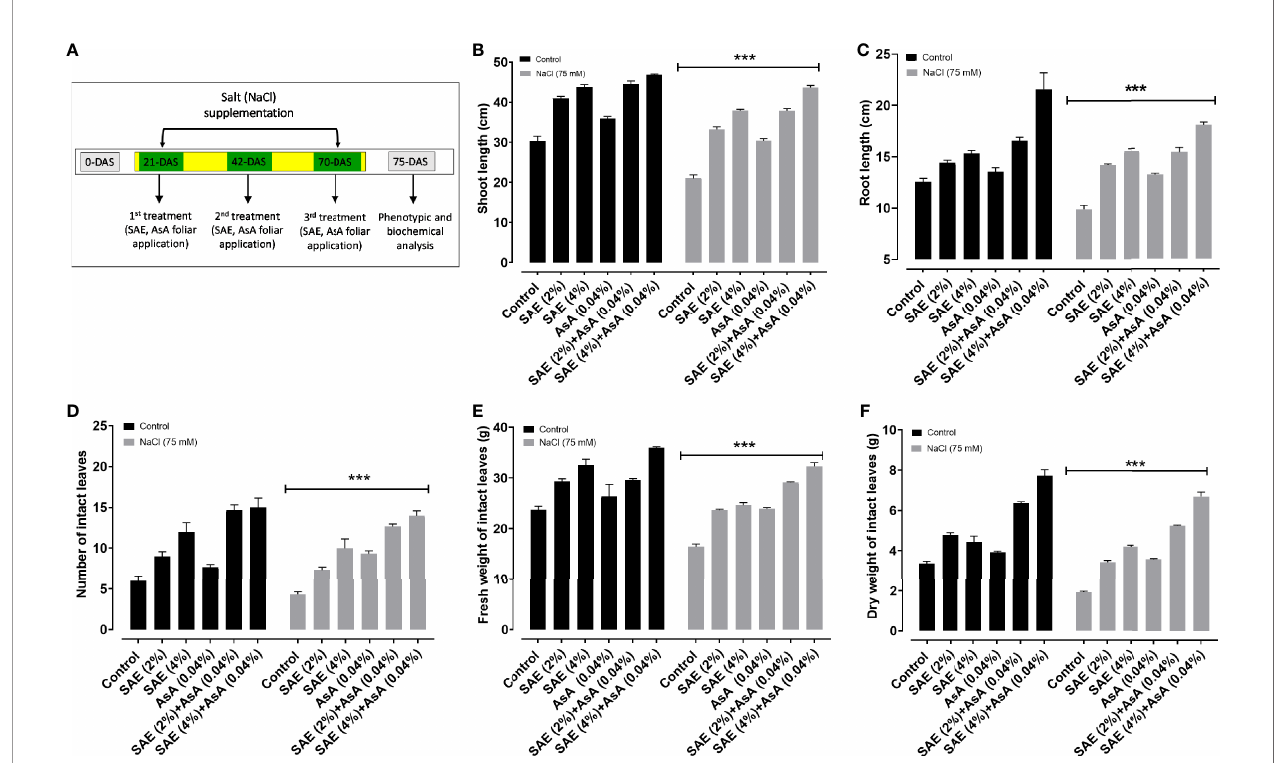
FIGURE 2 | Effect of Sargassum aqueous extract (SAE) on different vegetative growth parameters. (A) Schematic representation of the experimental setup; (B) shoot length; (C) root length; (D) the total number of intact leaves; (E) fresh weight of intact leaves; (F) dry weight. Error bars of quantitative data represent ± SEM (*** p < 0.005). FW, fresh weight; DW, dry